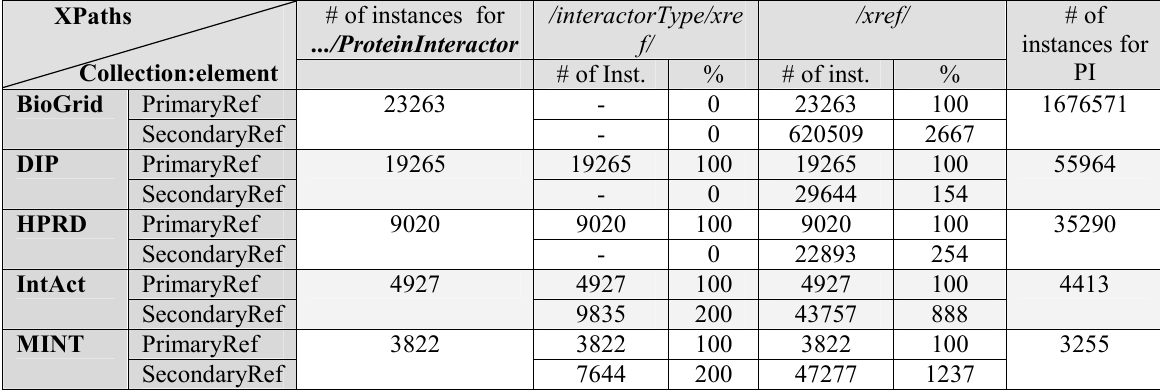
Table 4: Usage of PrimaryRef vs. SecondaryRef for two different